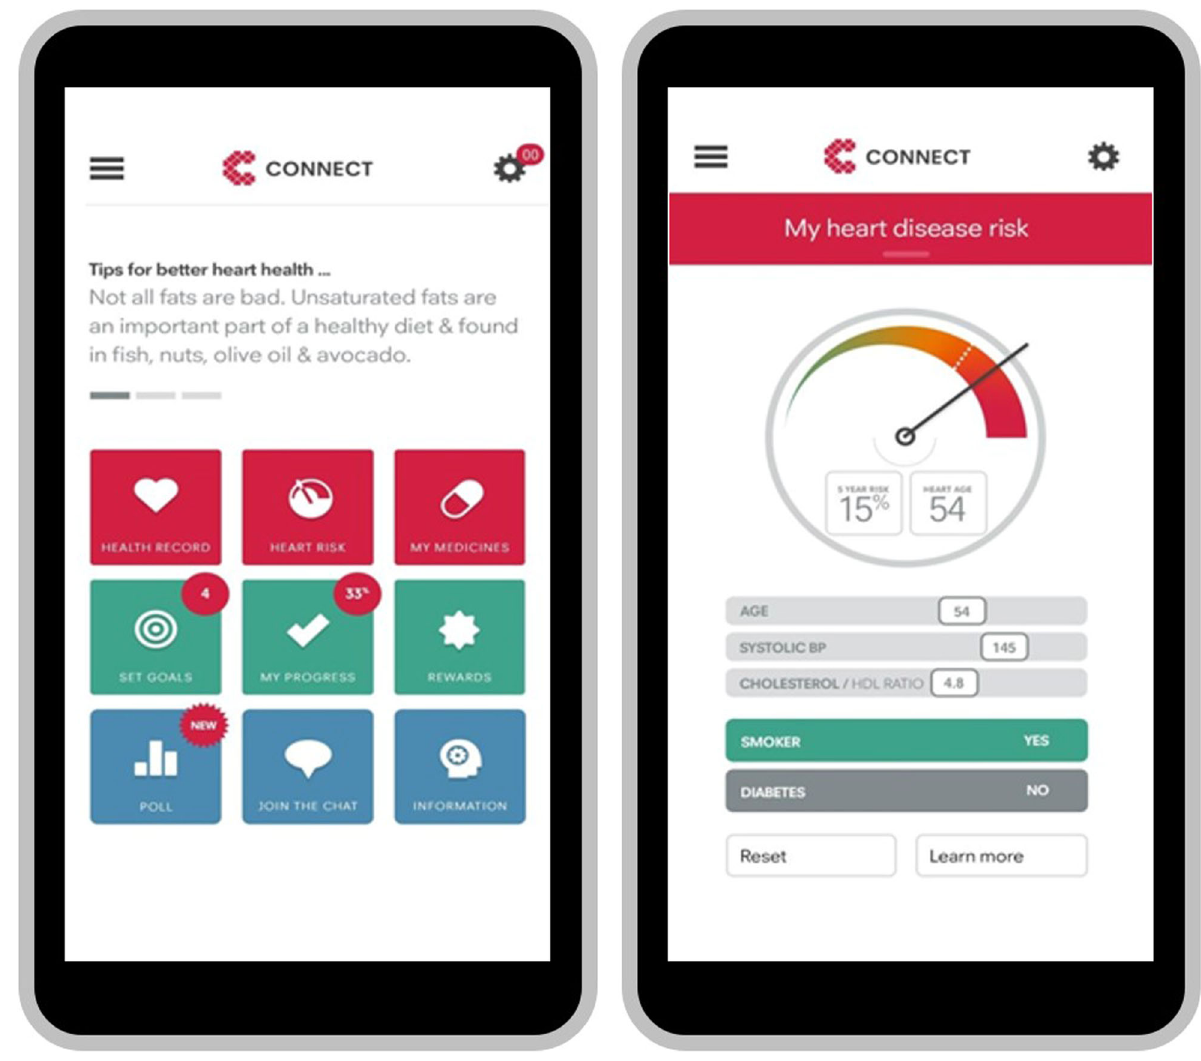
Fig. 2 Intervention screen